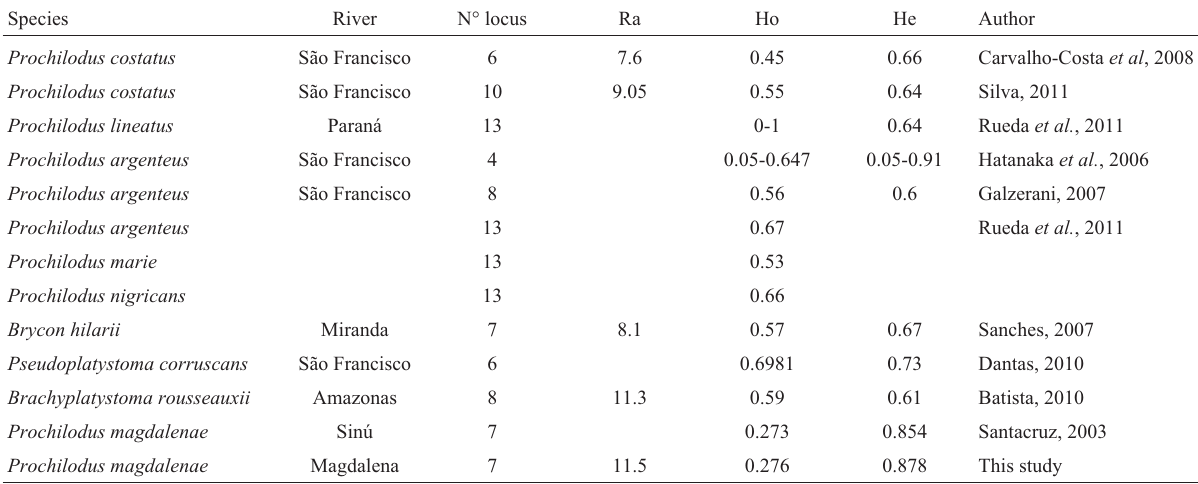
Table 4 - Comparative analysis parameters of genetic diversity in other studies using microsatellite marker in different species of migratory fish that in- habit South America rivers. Ra: allelic richness; Observed (Ho) and Expected (He) heterozygosity. Species River N° locus